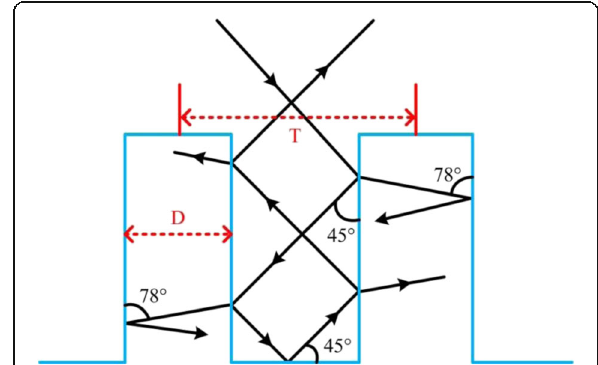
Fig. 6 The transmission path of incident light on the surface of microstructured silicon